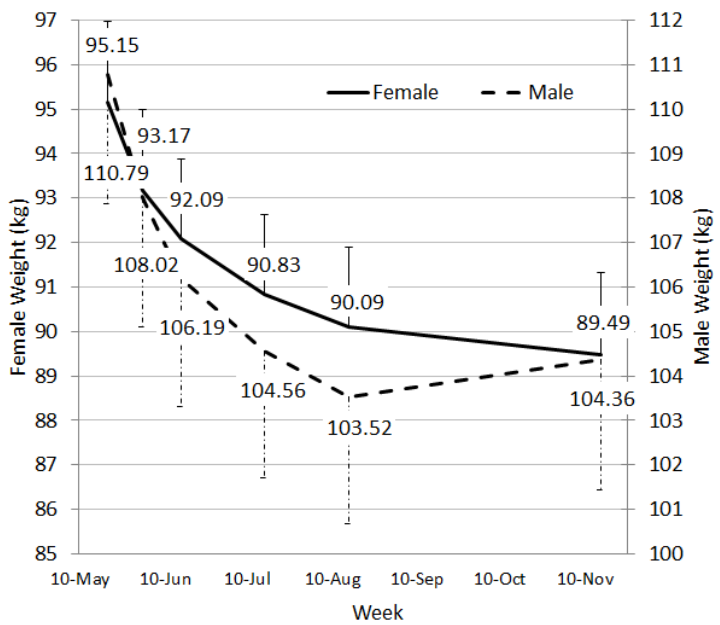
Figure 3. Adjusted weight loss values (kilograms) through the trial period. Error bars represent 1 standard error. 1 standard